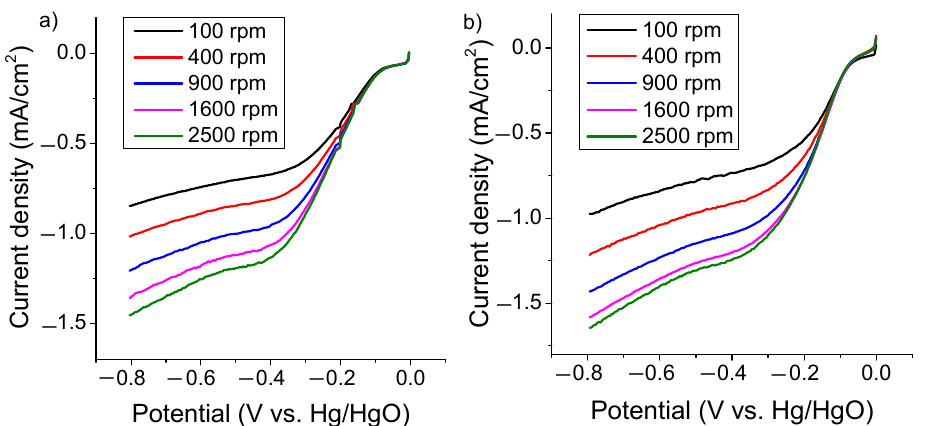
Figure 6. Linear sweep voltammograms at various electrode rotation rates from 100–2500 rpm for ( a ) PNDC, and ( b ) SiPNDC at 50 mV/s .